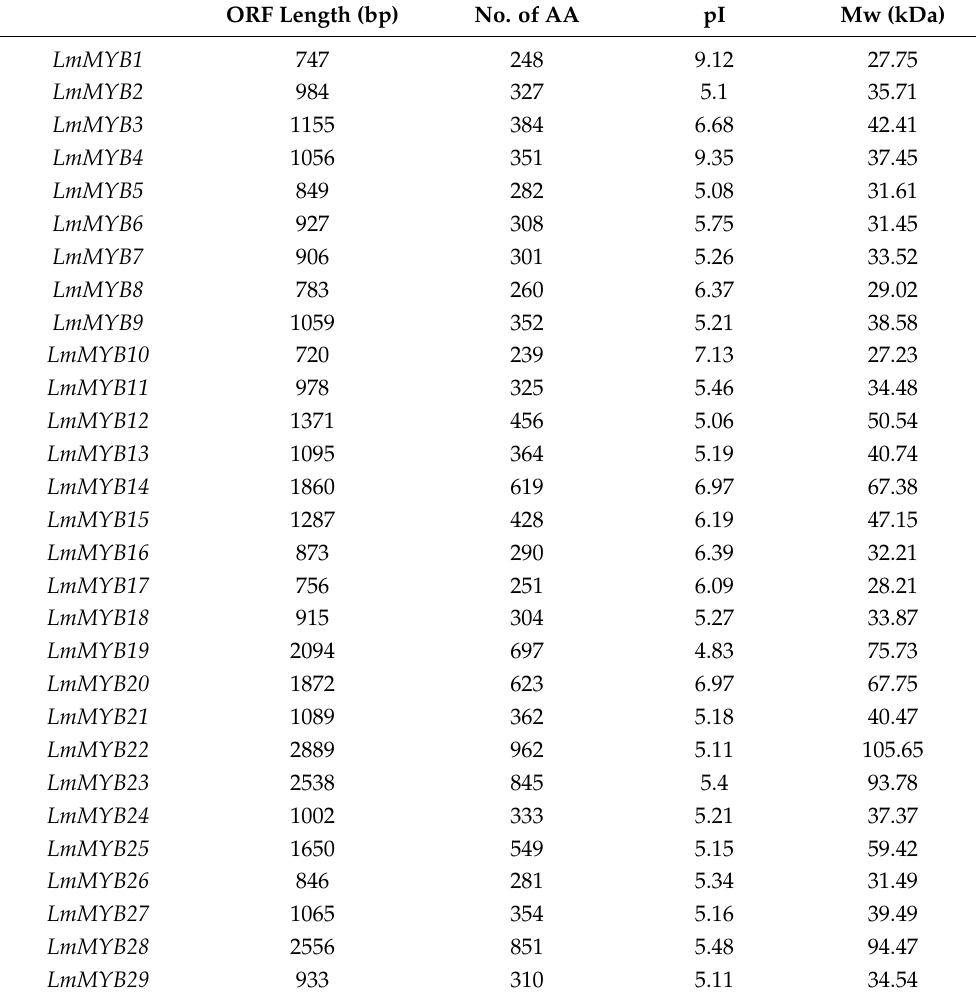
Table 2. R2R3-MYB family members identified in Lolium multiflorum